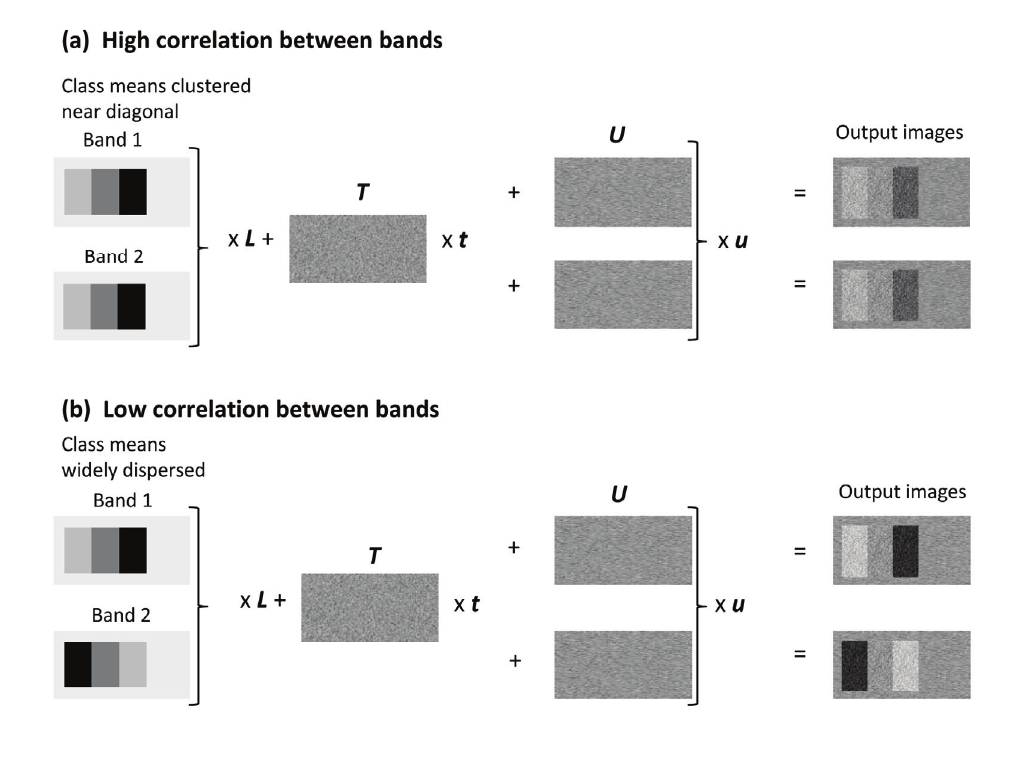
Figure 5. Overview of the construction of the simulated data with varying degrees of correlation between bands. (a) Construction of an image with high correlation between bands (b) Construction of an image with low